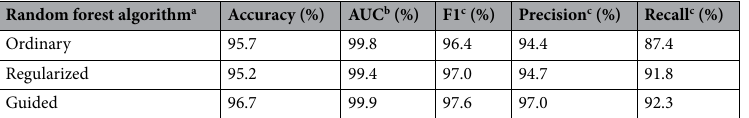
Table 1. Summary of the highest accuracy with which the emm -type was inferred when the three tested random forest algorithms were applied to the optimal set of response regulator allele types of group A Streptococcus . Predictions were made using tenfold cross validation and 10 replicates. a The optimal sets for the Ordinary, Regularized, and Guided random forests were [ mga2 , lrp , and gntR_spy0715 ], [ mga2 , lrp , copY , and crgR ], and [ mga2 , lrp , spy1934 , gntR_spy0715 , rivR , M28_spy1337 , spy1325 , gntR_spy1602 , spy1817 , and crgR ], respectively. b AUC = Multiclass classification area under the receiver operating characteristic curve. c Division by zero errors have been excluded from this